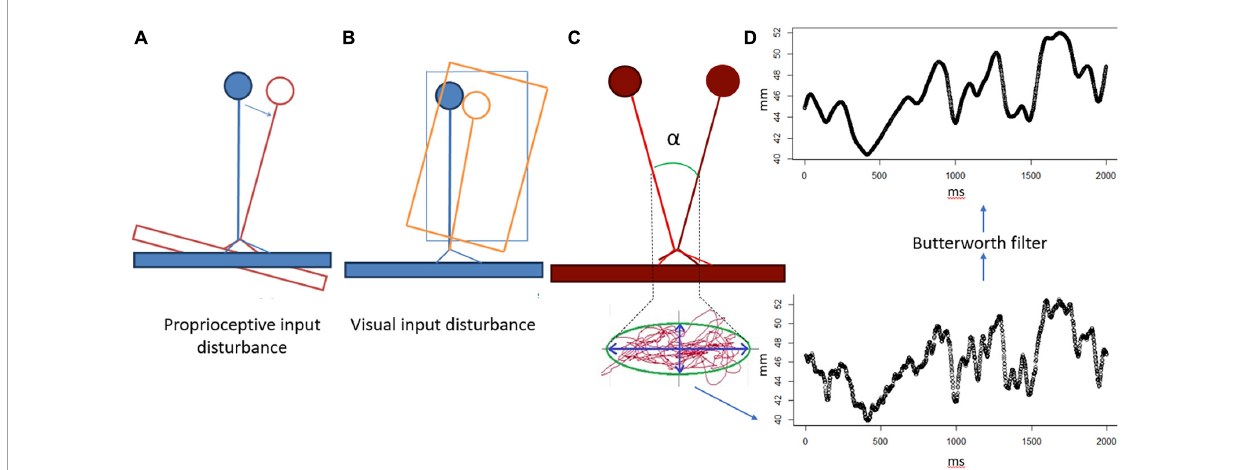
FIGURE2 Neurocom data processing. (A) Sway-referenced platform for proprioceptive input disturbance. (B) Sway-referenced visual surround for visual input disturbance. (B) Center of Pressure trace and sway angle. (D) Stabilogram alignment with Butterworth filter.